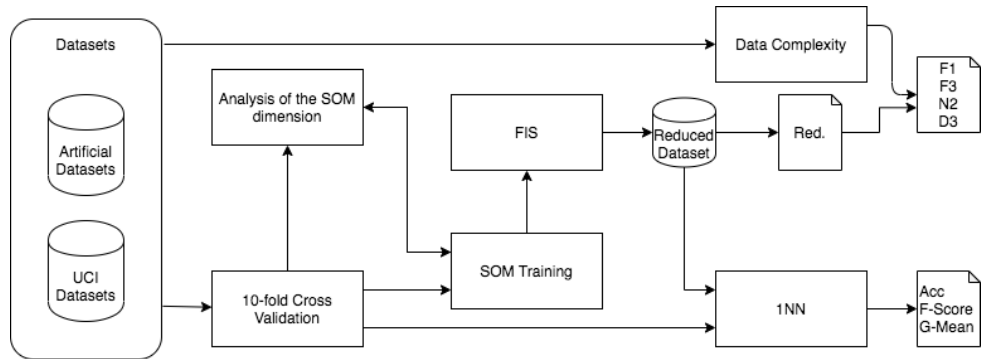
Figure 2. Schema of experimental methodology.